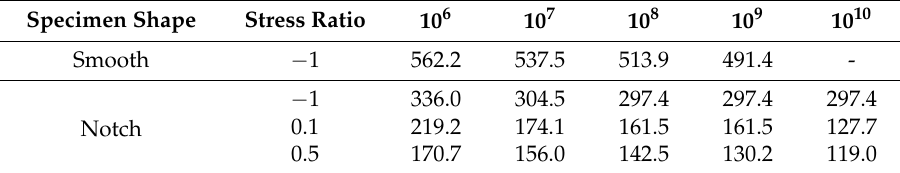
Table 1. Fatigue strength at different number of loading cycles.